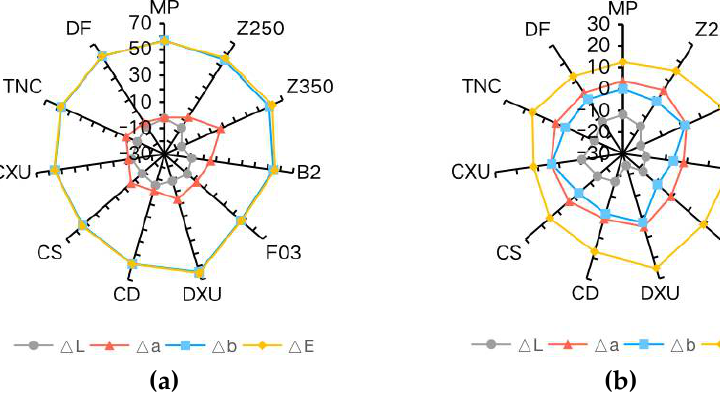
Figure 3. Radar graphs demonstrating CIE L*, a*, and b* value changes after immersion in colorants for 28 days: ( a ) curry ( b ) coffee ( c ) wine.